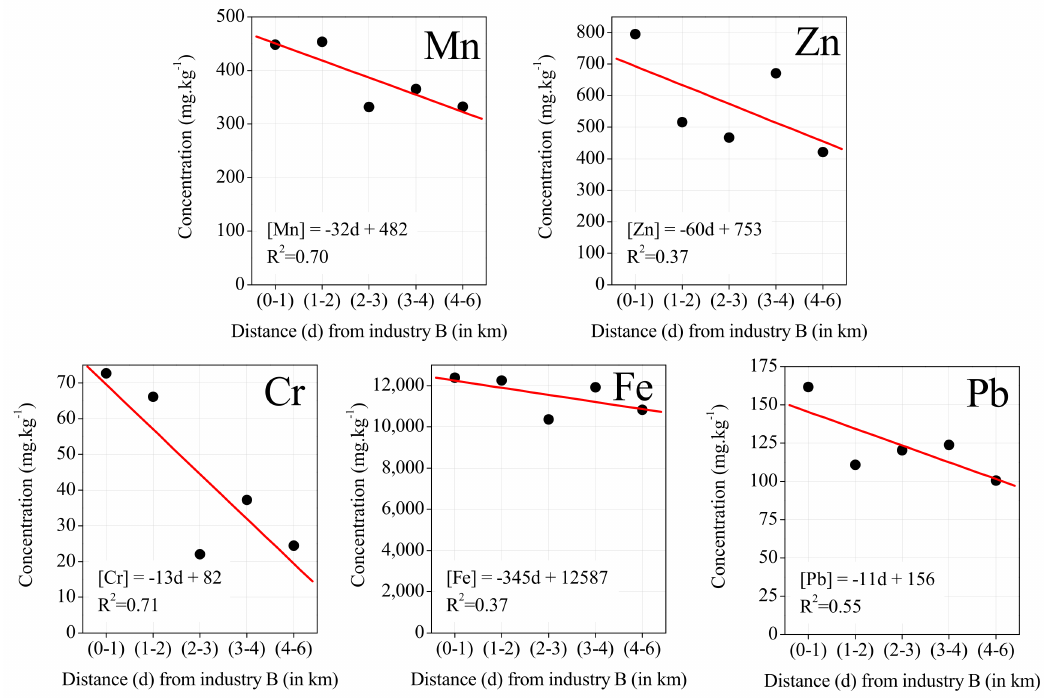
Figure 7. Mean elemental concentration versus distance to the steelworks.